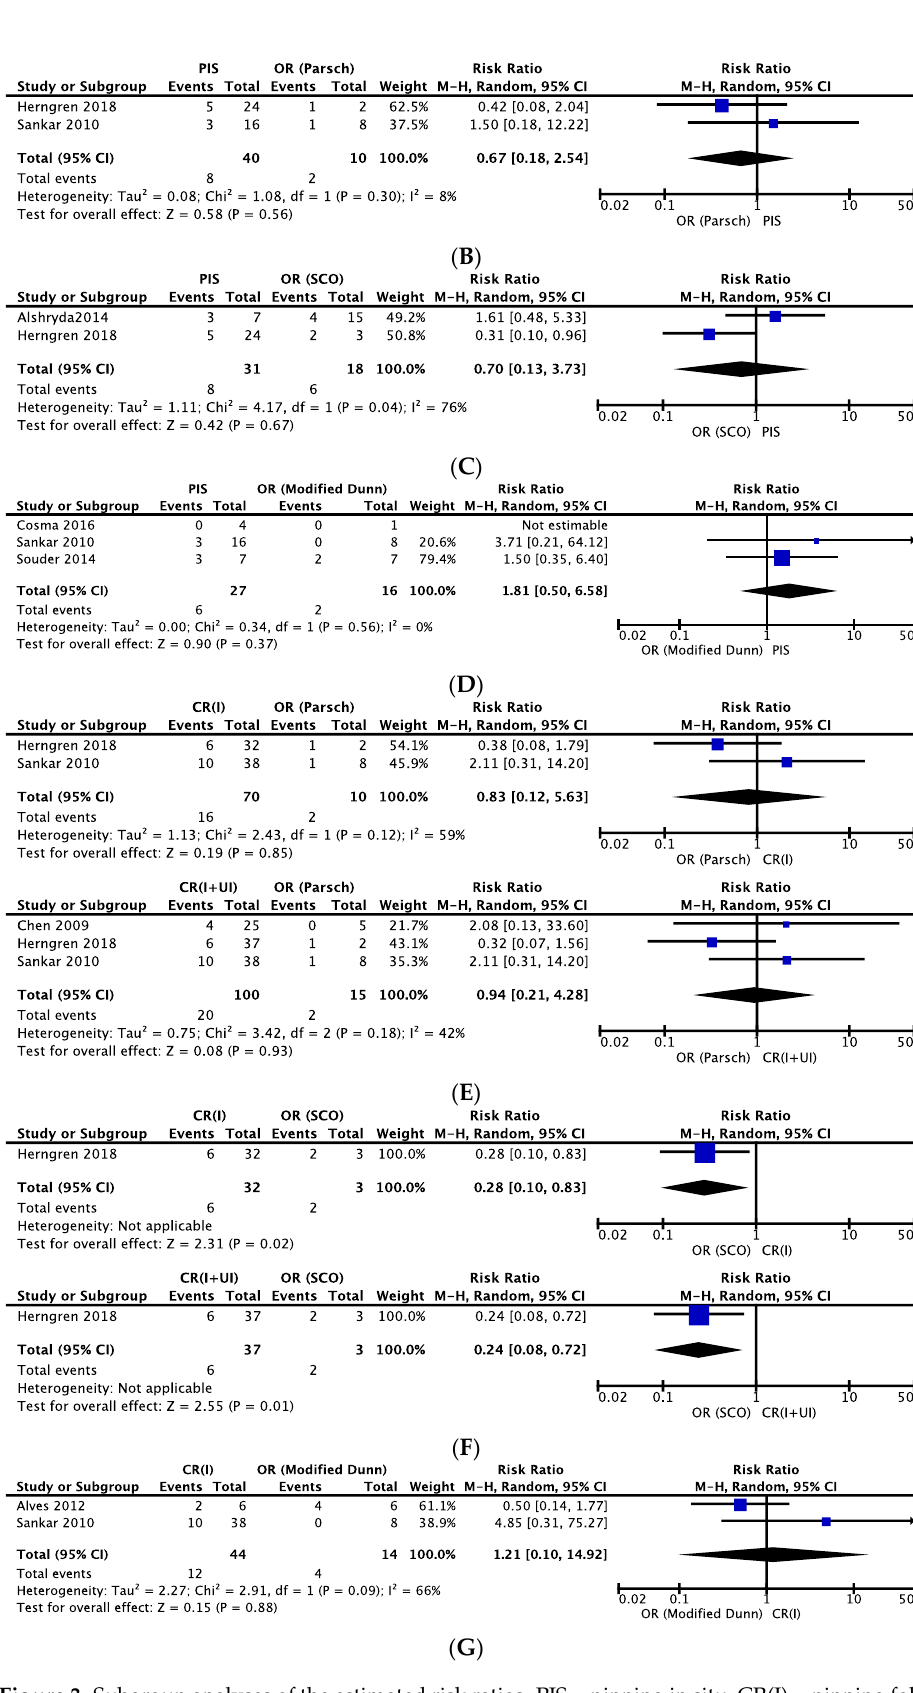
Figure 3. Subgroup analyses of the estimated risk ratios. PIS = pinning in situ, CR(I) = pinning